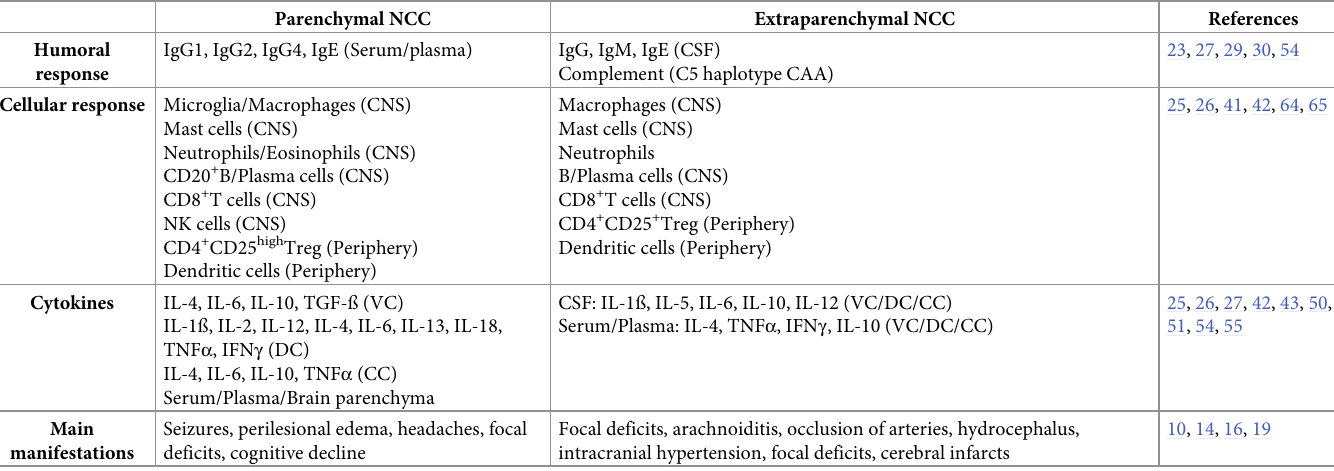
Table 1. Key cellular and humoral effectors associated with parenchymal and extraparenchymal NCC. Parenchymal